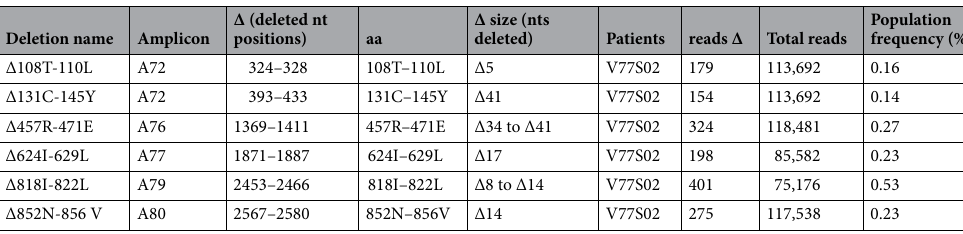
Table 6. Variant B.1.617.2 (Delta).